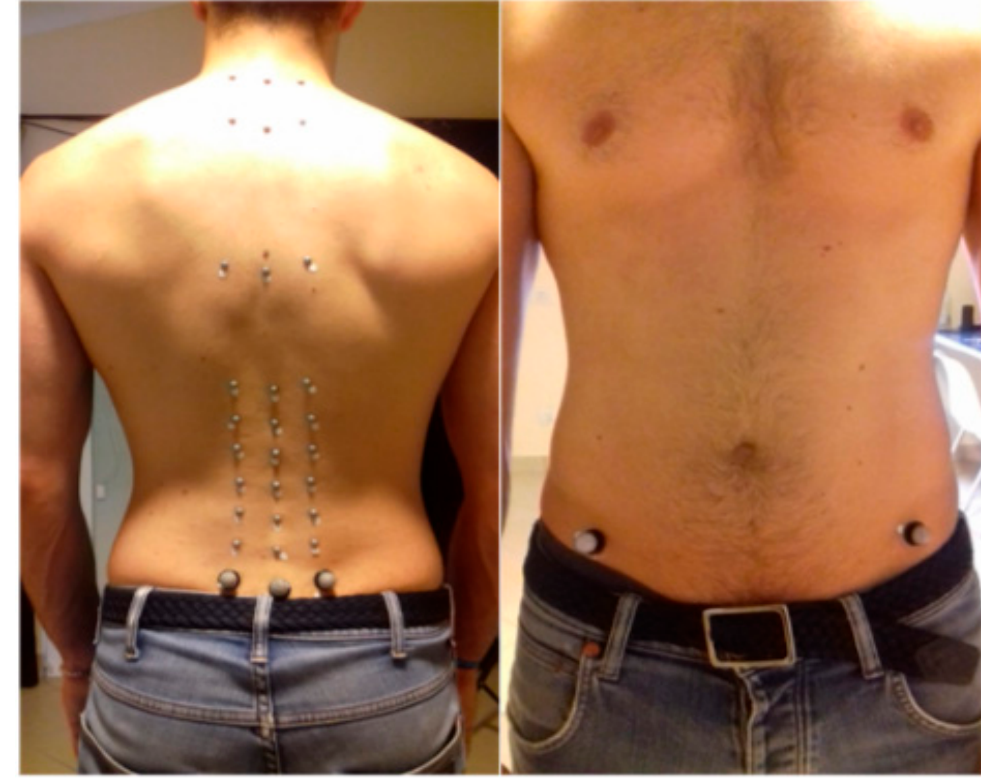
Figure 1. Positioning of the 32 markers.